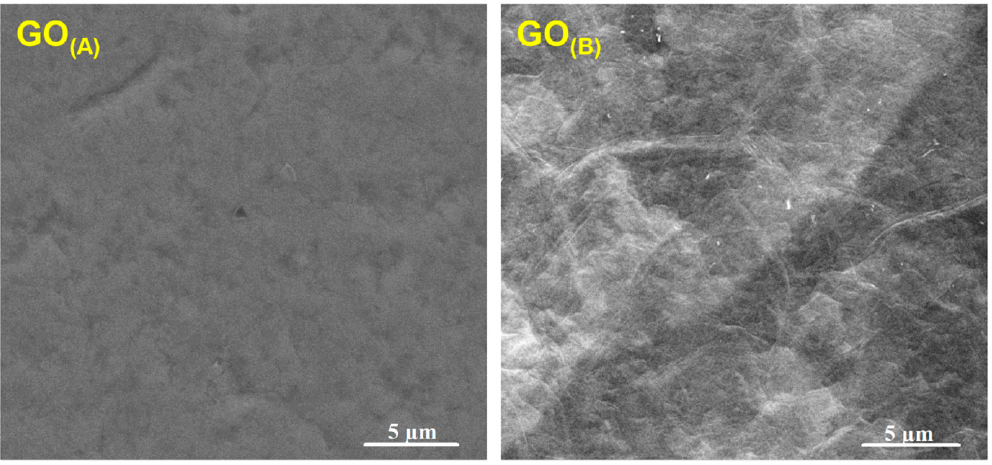
Figure 1. SEM micrographs presenting surface morphology of GO (A) and GO (B) paper.